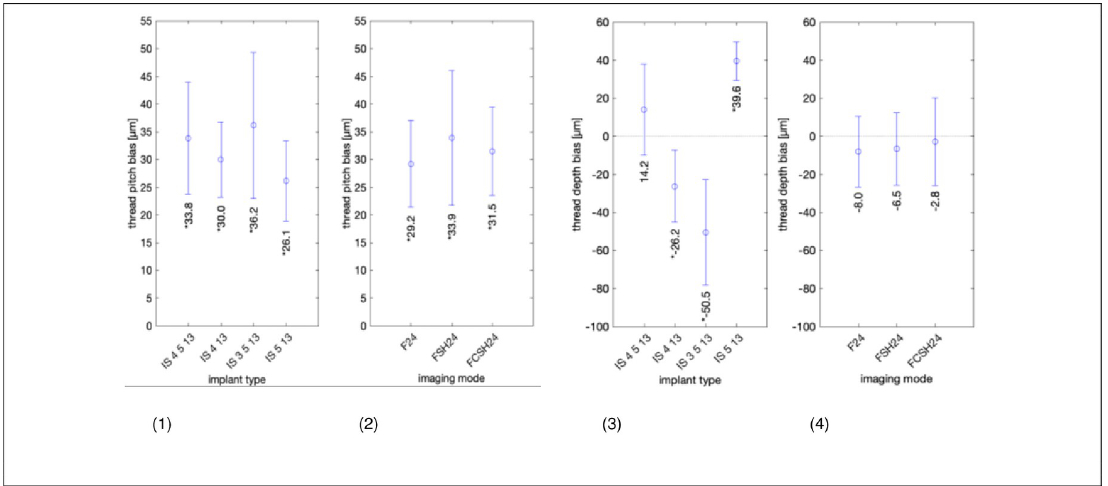
Fig 9. Bias and dependence of measuring implant thread pitch (left) and thread depth (right) with ultrasound. Left to right: (1) Bias in micrometer with 95% CI for each of the 4 implant samples. (2) Bias in micrometer 95% CI for the 3 imaging modes (F24, FSH24, and FCSH24). (3 and 4) Same data as (1 and 2) but showing thread depth bias in micrometers. The complete data are shown in S4 and S5 Figs, for implant thread pitch and thread depth,